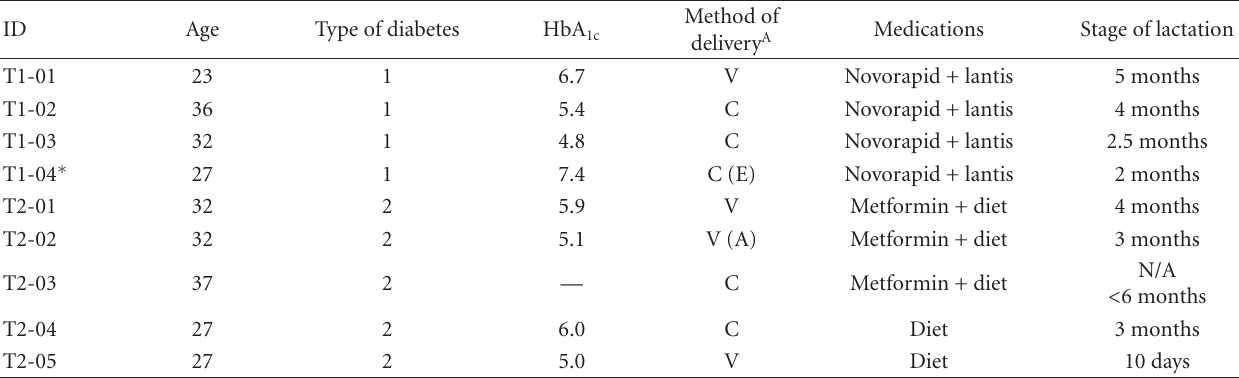
Table 1: Demographic details of mothers with